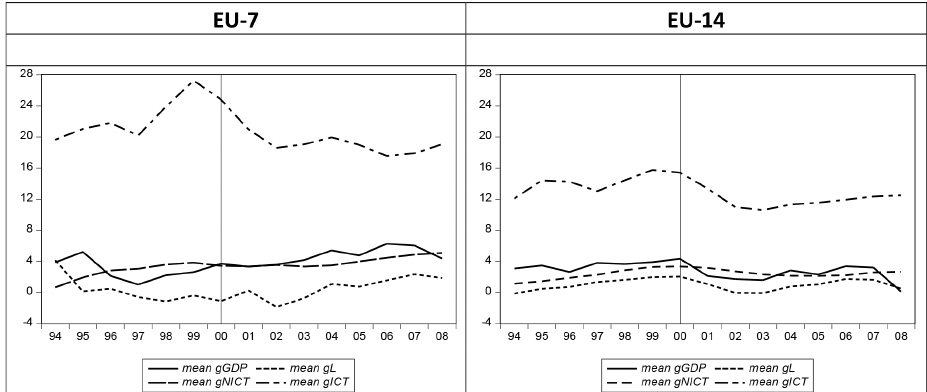
Fig. 2. The mean of the growth of output and input factors of the production function Source :